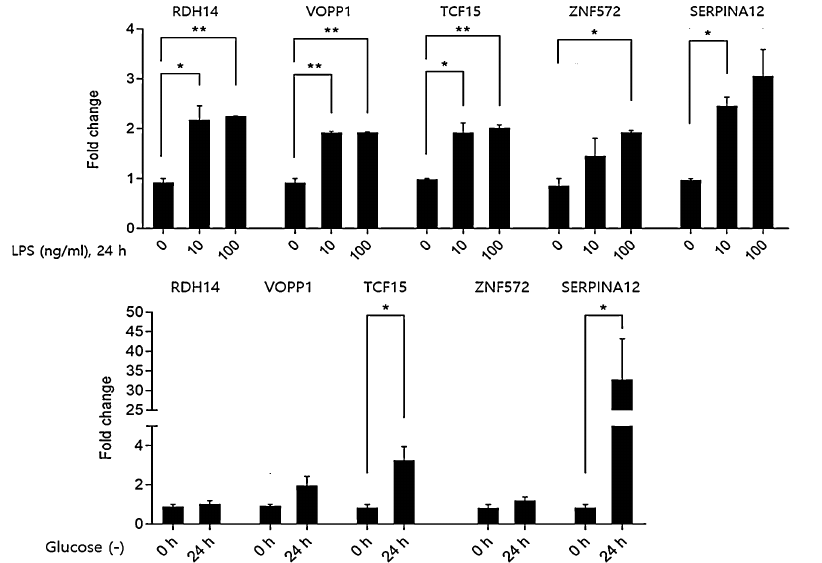
Figure 6. Effect of liposaccharide and glucose depriviation on the expression of the candidate genes in HTR-8/ SVneo cells. Asterisks indicate levels of significance of differential expression (* P ≤ 0.05, ** P ≤